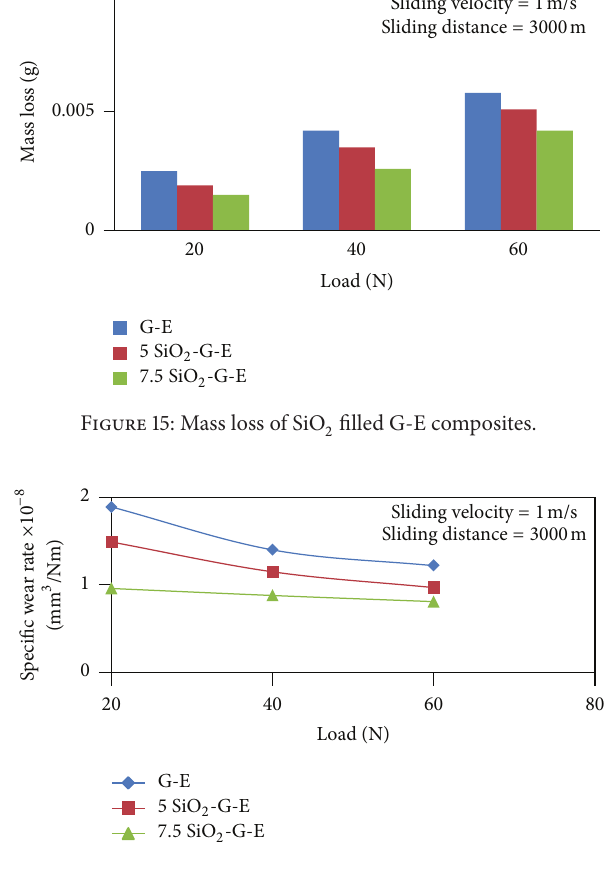
Figure 16: Specific wear of SiO 2 filled G-E composites.